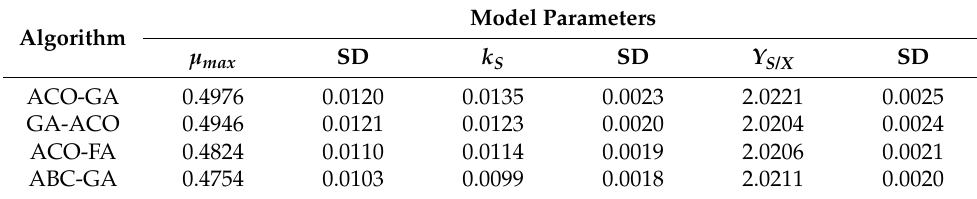
Table 8. Comparison of the model parameter estimates obtained by ABC with the published